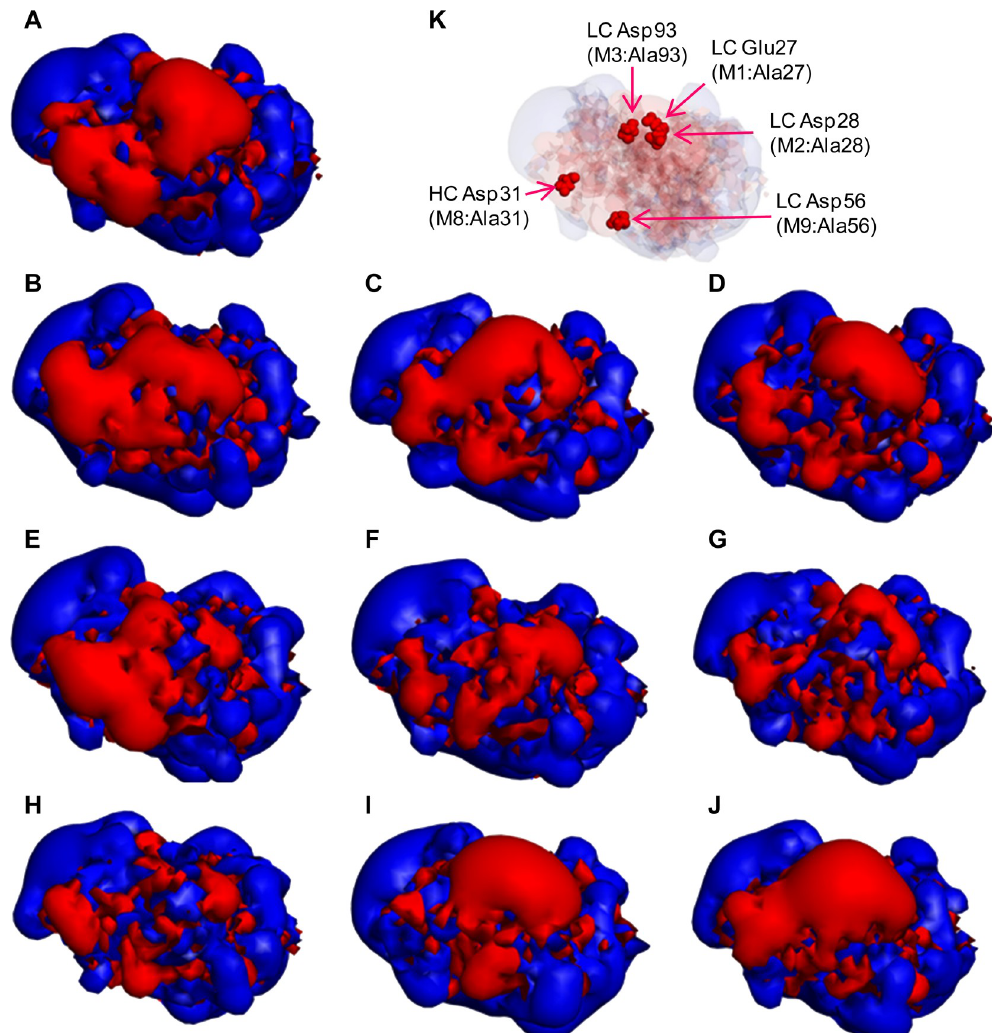
Fig 2. Electrostatic potential surfaces of Fabs of WT and mutants. (A) WT, (B) M1, (C) M2, (D) M3, (E) M4, (F) M5, (G) M6, (H) M7, (I) M8, and (J) M9: The red and blue contours indicate the − 1 and +1 k B T/e isosurface potentials. (K) Connolly surface (transparent gray color) with a CPK model (red color) of five negatively charged amino acids: light chain (LC) Glu27, LC Asp28, LC Asp93, LC Asp56, and heavy chain (HC) Asp31. The LLPS propensity of all mAbs at 50 mg/mL in low-ionic-strength buffer A is shown in Fig 3A. Single-charge deletion mutants (M1, M2, and M3) still underwent LLPS at 4˚C how- ever, they required more time to undergo LLPS than the WT. The WT underwent LLPS within 3 h of incubation at 4˚C, whereas the appearances of mutants M1, M2, and M3 remained cloudy and homogeneous for several hours. These mutants ultimately underwent LLPS follow- ing overnight incubation at 4˚C. LLPS was clearly mitigated in double- and triple-charge dele- tion mutants (M4, M5, M6, and M7), even after overnight incubation. M8 and M9 did not undergo clear phase separation at 4˚C; however, their solutions were opaque, unlike those of M4–M7. In general, the opaque appearance could be due to both LLPS and fine precipitation. To explain the opacity of M8 and M9 solutions, we conducted a larger-scale LLPS experi- ment with centrifugation. M8 and M9 solutions showed opacity after 24 h incubation at 4˚C